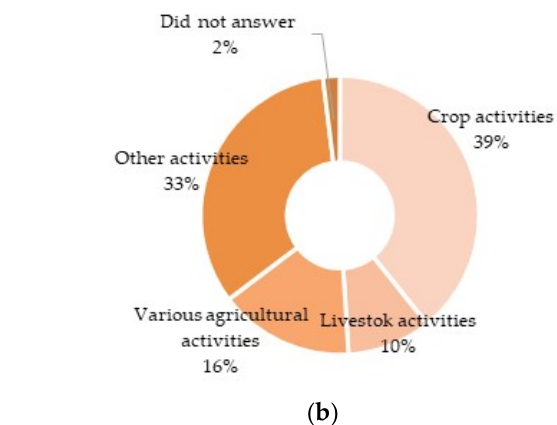
Figure 1. Structure of Lithuanian agricultural cooperatives by the number of members ( a ) and types and sectors of activity ( b ) (N = 102 Cooperative survey data, 2019).